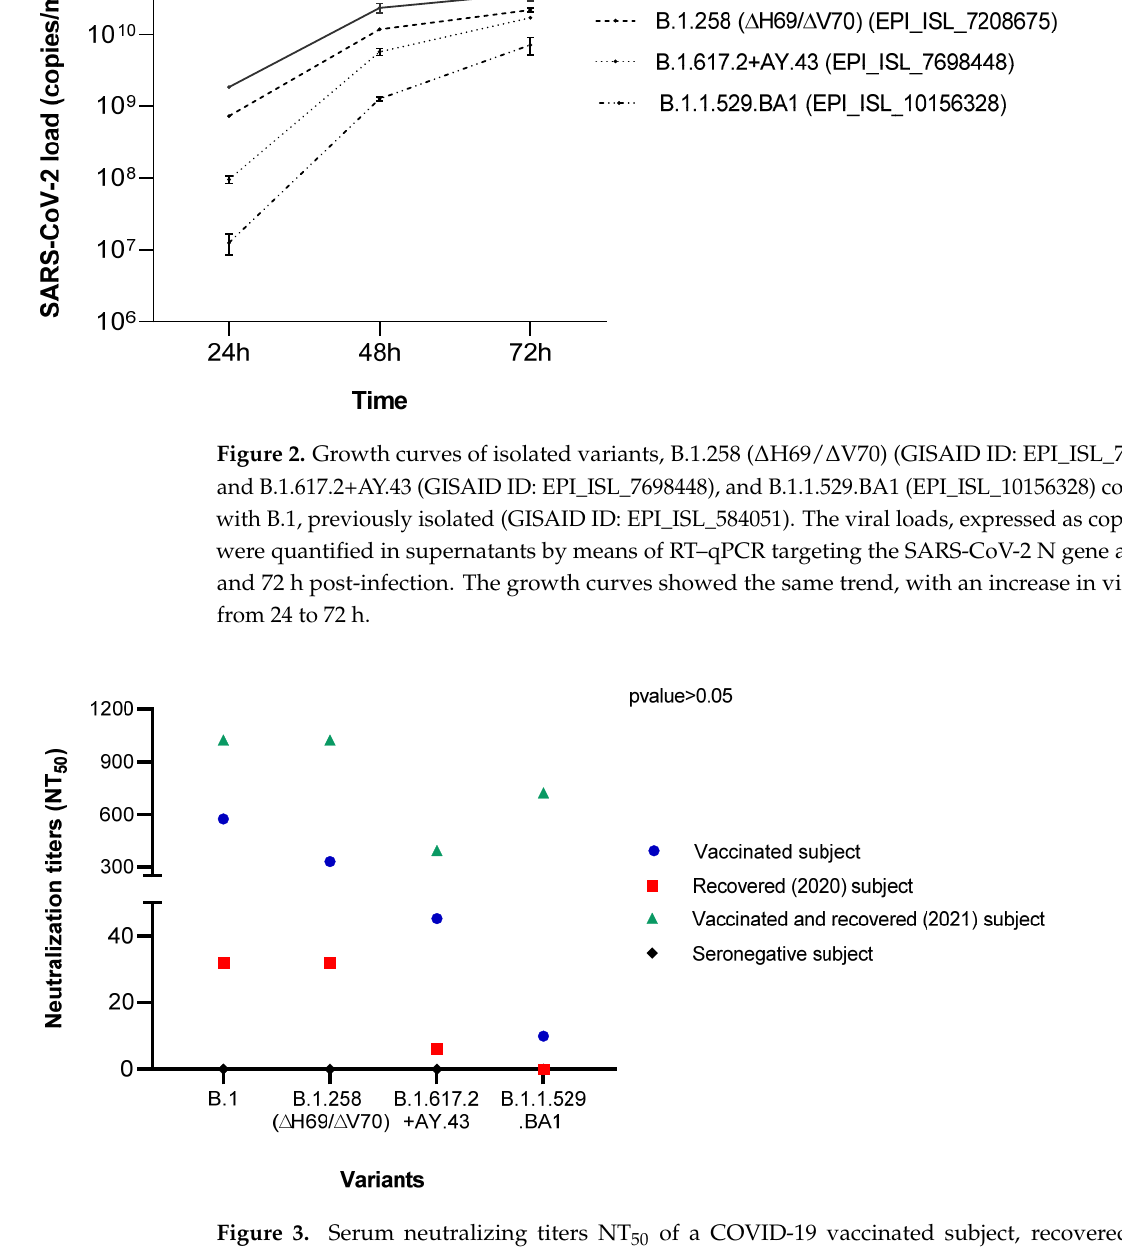
Figure 3. Serum neutralizing titers NT 50 of a COVID-19 vaccinated subject, recovered (2020) patient, vaccinated and recovered (2021) patient, and seronegative subject, against B.1 (GSAID ID: EPI_ISL_584051), B.1.258 ( ∆ H69/ ∆ V70) (GISAID ID: EPI_ISL_7208675), B.1.617.2+AY.43 strain (GISAID ID: EPI_ISL_7698448), and B.1.1.529.BA1 (GISAID ID: EPI_ISL_10156328). NT 50 values of sera were obtained by microneutralization assay and determined by means of the Reed and Muench method.